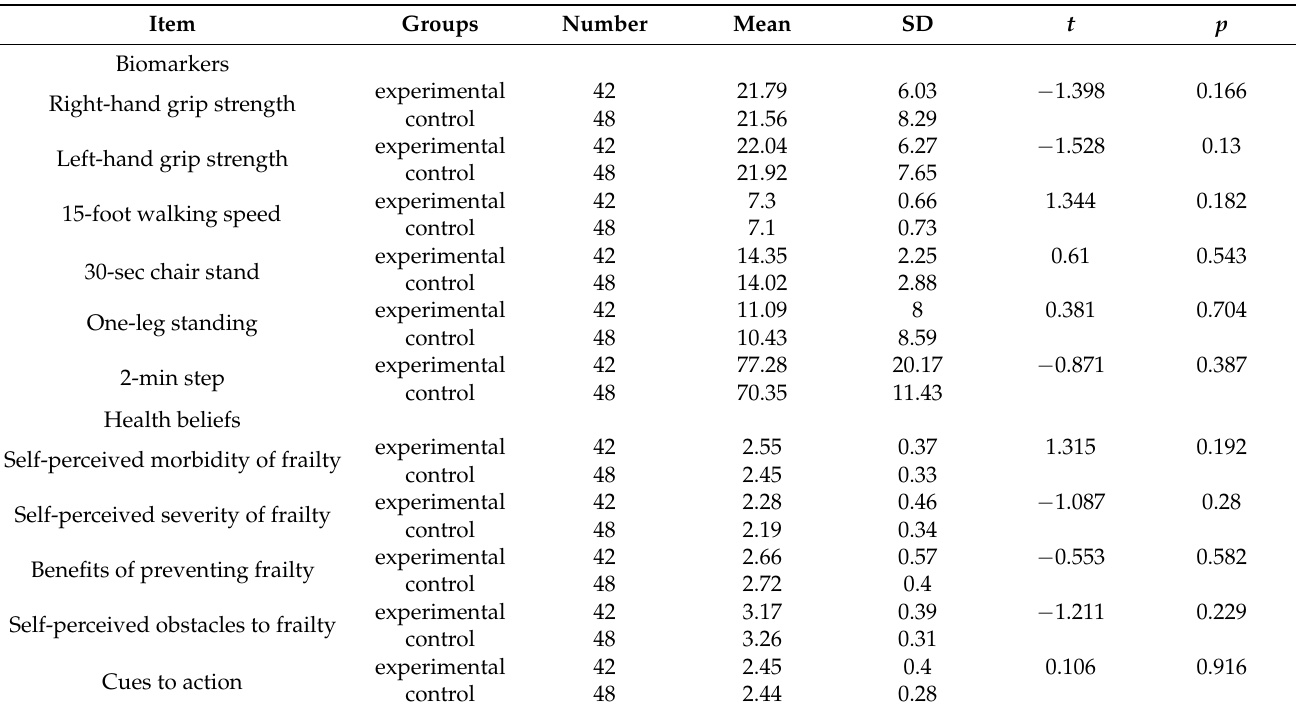
t = − 9.28, p < 0.05), one-leg standing balance (paired t = − 4.65, p < 0.05), 2-minute step test (paired t = − 5.28, p < 0.05), perceived susceptibility of frailty (paired t = − 16.83, p < 0.05), perceived seriousness of frailty (paired t = − 14.98, p < 0.05), benefits of preventing frailty (paired t = − 14.39, p < 0.05), barriers of preventing frailty (paired t = 7.11, p < 0.05), and cues to action (paired t = − 13.19, p < 0.05) (Table